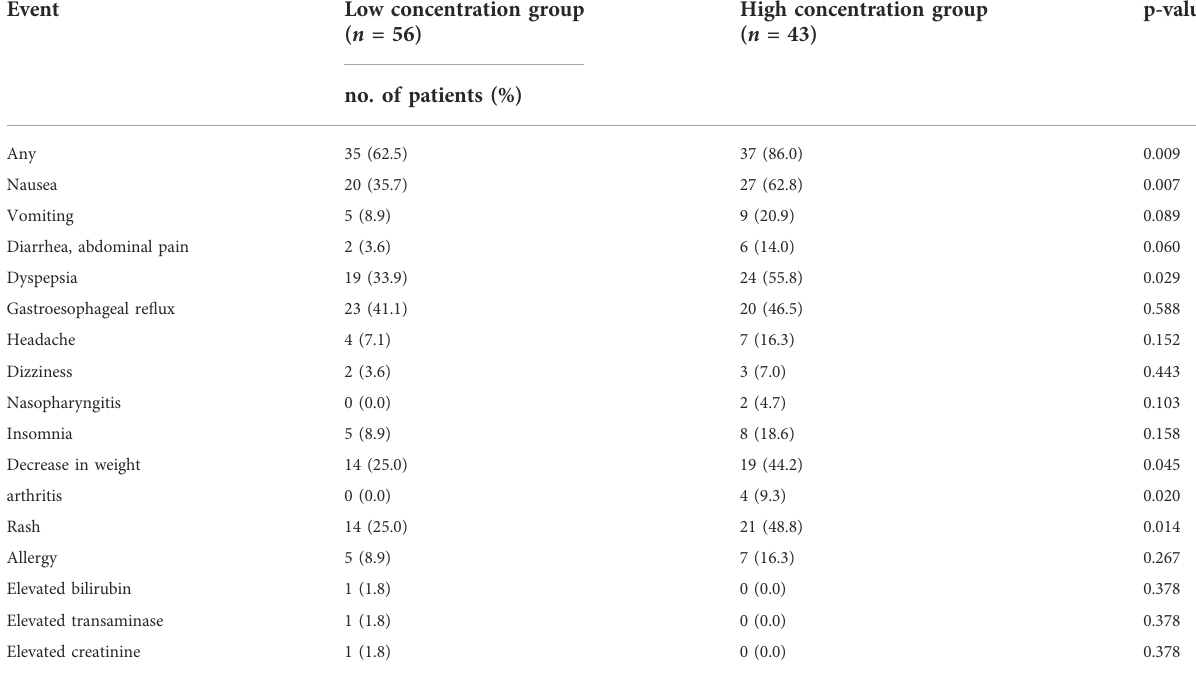
TABLE 4 Adverse events in the overall